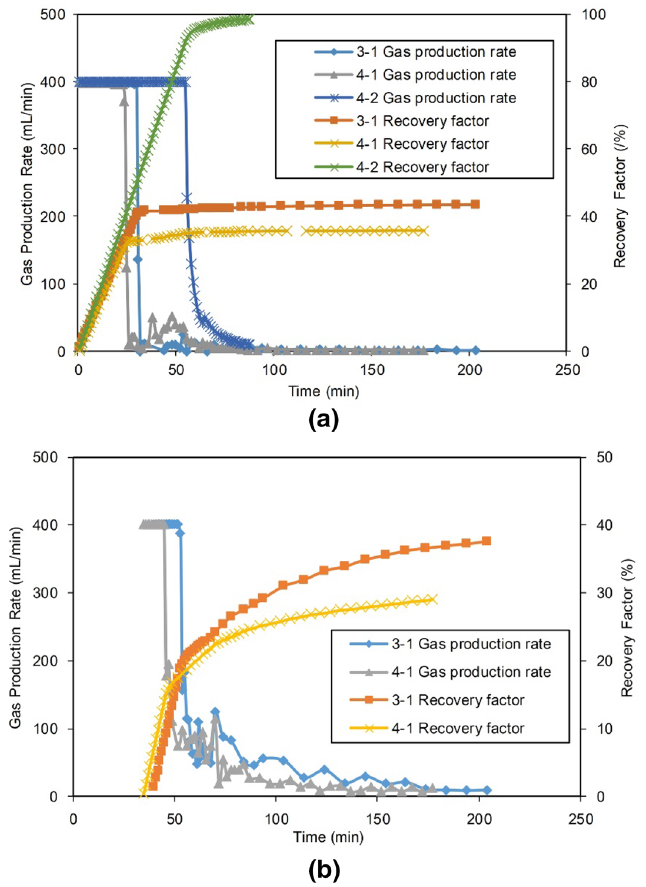
Figure 19. Gas production performance of Experiments 3-1 and 4-1: ( a ) Gas production of Gas Well 1 in the MZ, and ( b ) Gas production of the Gas Well 2 at point A.